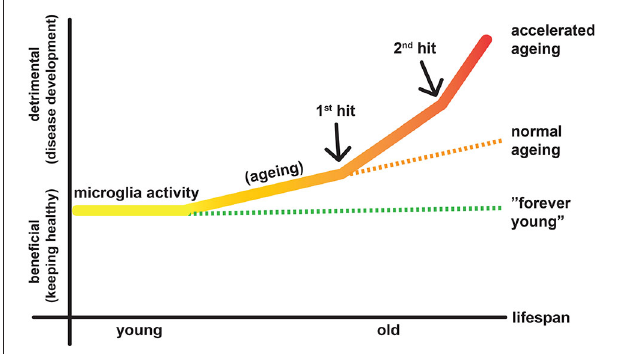
FIGURE 1 | Diagram illustrates putative activities of microglia in aging and lesioned brain . Aging constitutes the continuous factor that transforms some of the microglia to the destructive mode, which may contribute to development of diseases. When there is a lesion, e.g., TBI or stroke (1st hit), some microglia become M1 type, which causes further neurodegeneration while a larger population is still M2 type, which helps healing the lesion environment. In addition, infiltration of the blood-derived immune cells (monocytes/macrophages, lymphocytes) forms the second wing of the inflammatory response and may contribute to neuronal protection and disease